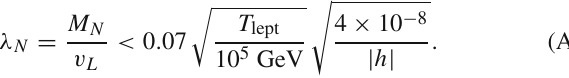
the aforementioned condition is met; this process